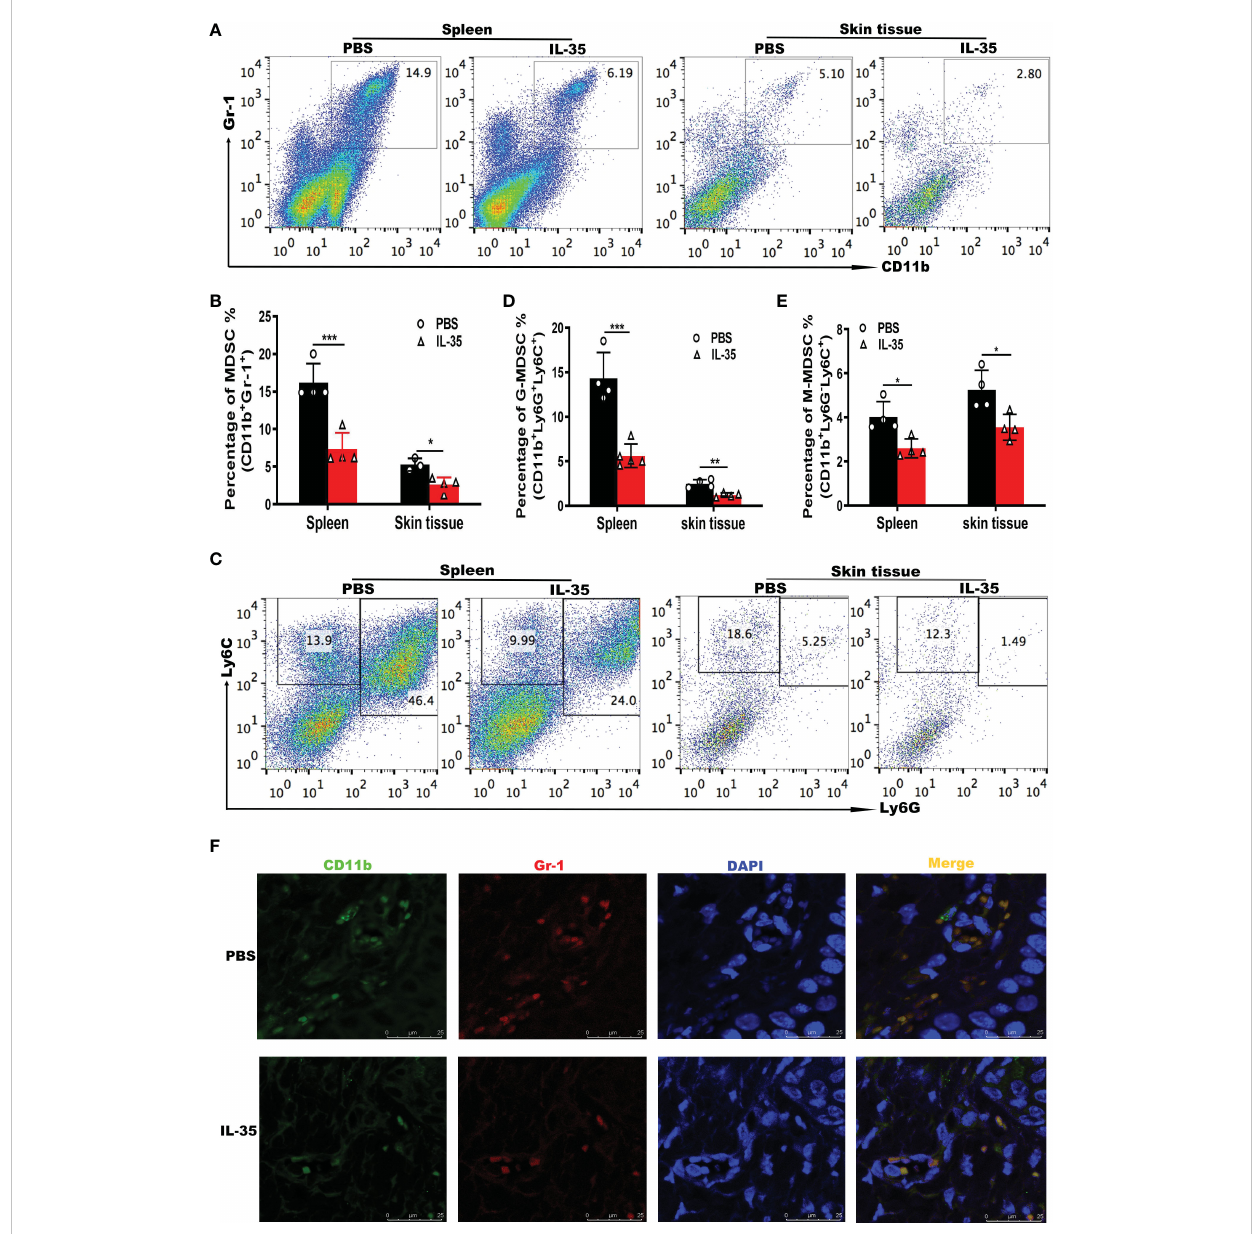
FIGURE 5 IL-35 suppresses MDSCs in fi ltration in mice with IMQ-induced psoriasis. (A) Representative fl uorescence-activated cell sorting plots of MDSCs (CD11b + Gr-1 + ) in the spleen and skin (gated on CD45) 24 hours after the last injection of IL-35. (B) Flow cytometry statistics of the results in (A) . (C) Representative fl uorescence-activated cell sorting plots of G-MDSCs (CD11b + Ly6G + Ly6C low ) and M-MDSCs (CD11b + Ly6G - Ly6C high ) in the spleen and skin (gated on CD45). (D – E) Quanti fi cation of fl ow cytometry results in (C) . (F) Immuno fl uorescence staining of in fi ltrated CD11b + Gr-1 + MDSCs in murine skin lesions (N = 6). Green represents anti-CD11b; red, anti-Gr-1; yellow, CD11b and Gr-1 merged; and blue, DAPI. Original magni fi cation, 400×. Data are presented as means ± standard deviation. *P < 0.05, **P < 0.01, ***P < 0.001. DAPI, 4 ’ ,6-diamidino-2-phenylindole; G-MDSC, granulocyte MDSC; IL, interleukin; IMQ, imiquimod; M-MDSC, mononuclear MDSC; MDSC, myeloid-derived suppressor